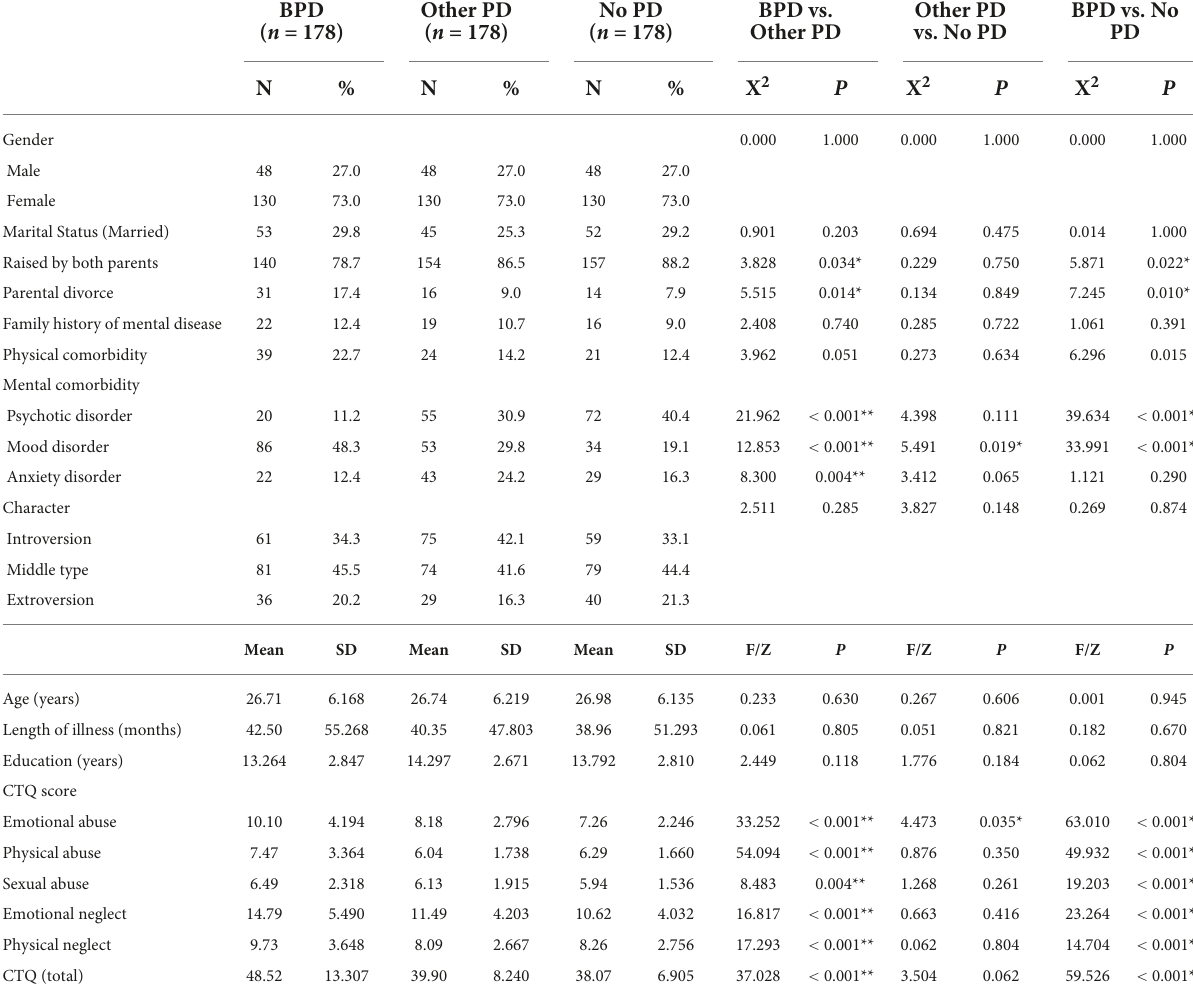
TABLE 1 Clinical and socio-demographic characteristics of BPD, other PD, and no PD